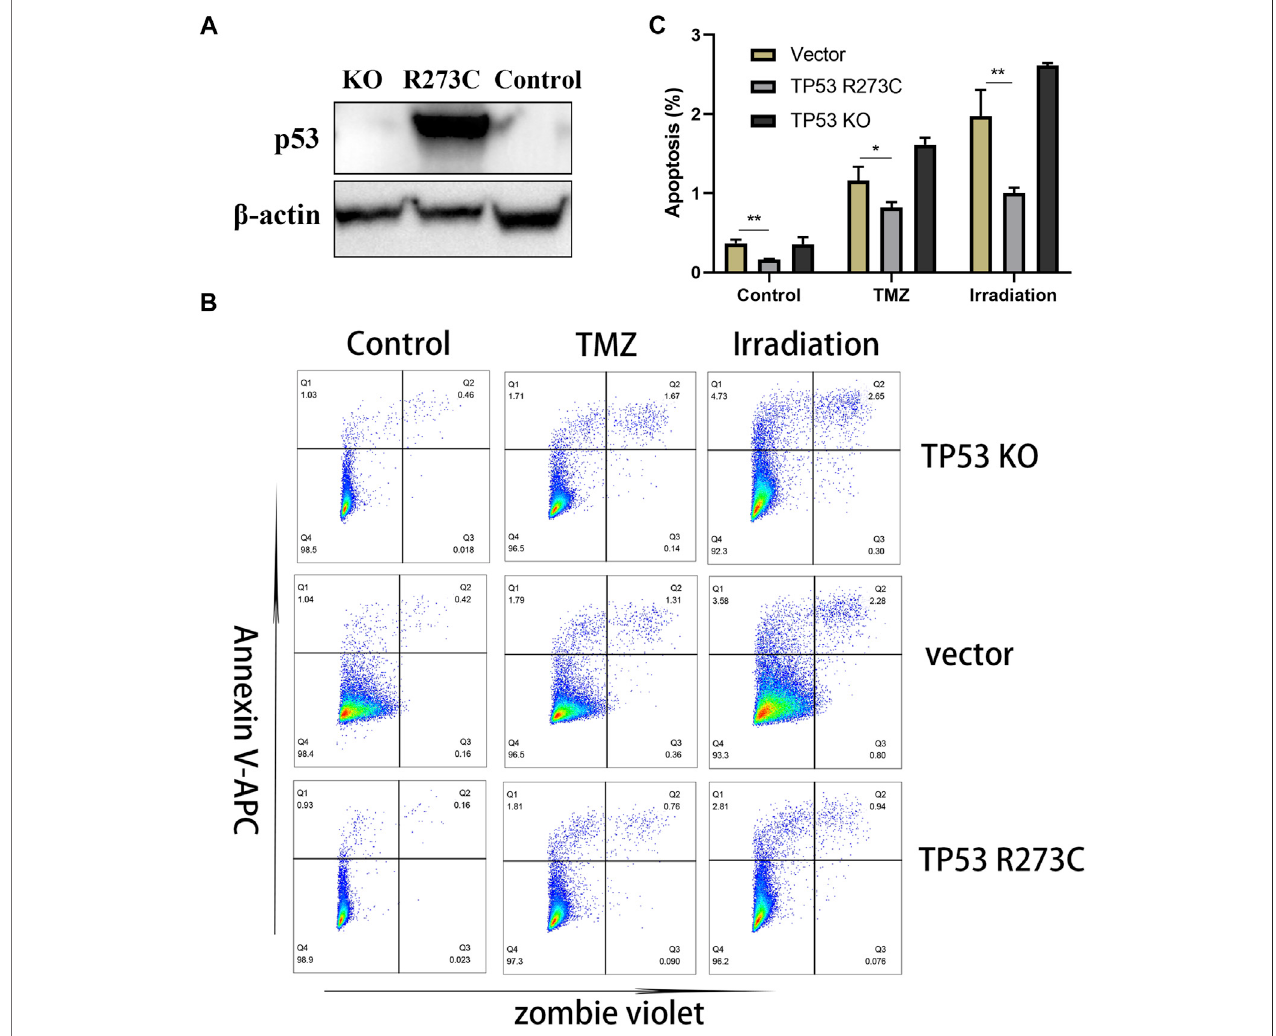
FIGURE 7 | Western blotting and functional assays. (A) WB results of TP53 expression in SW1088-TP53 KO , SW1088-TP53 R273C , and SW1088-Control (the empty vector). (B – C) Flow detection of apoptosis. Statistical signi fi cance: * 0.05 < p < 0.01, ** 0.01 < p < 0.001 for the multiple t -test.